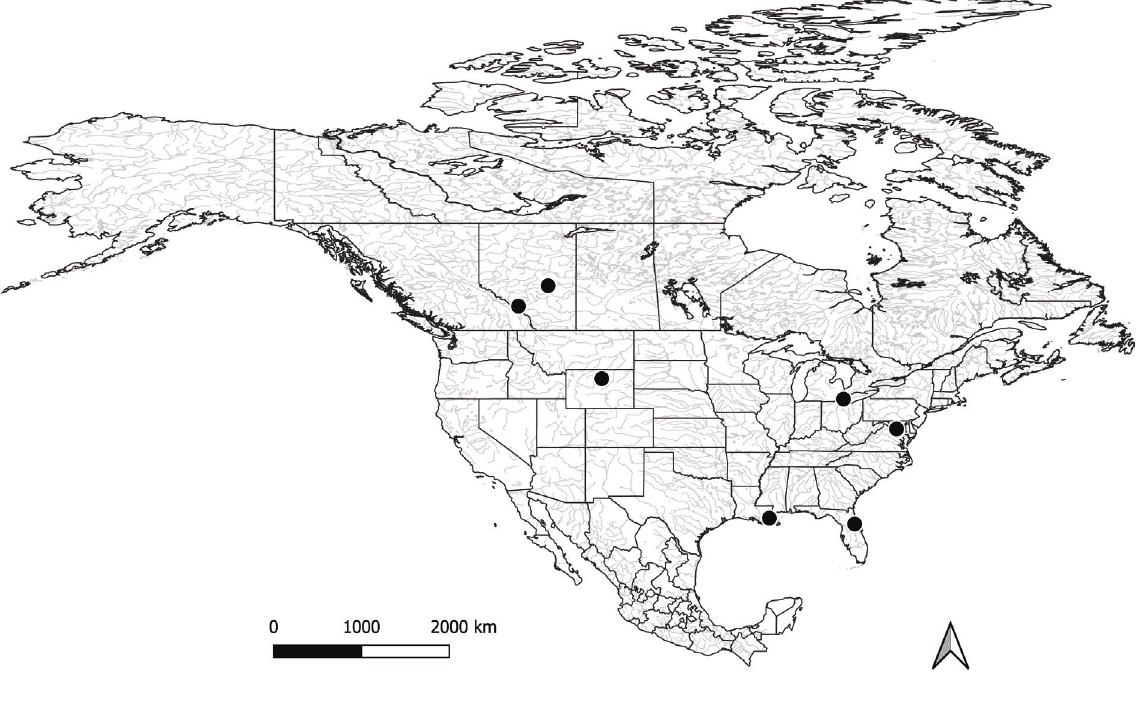
Fig. 1. Map of North America showing confirmed localities for Oxyloma salleana (L. Pfeiffer, 1850). Shown in gray are major rivers (USGS